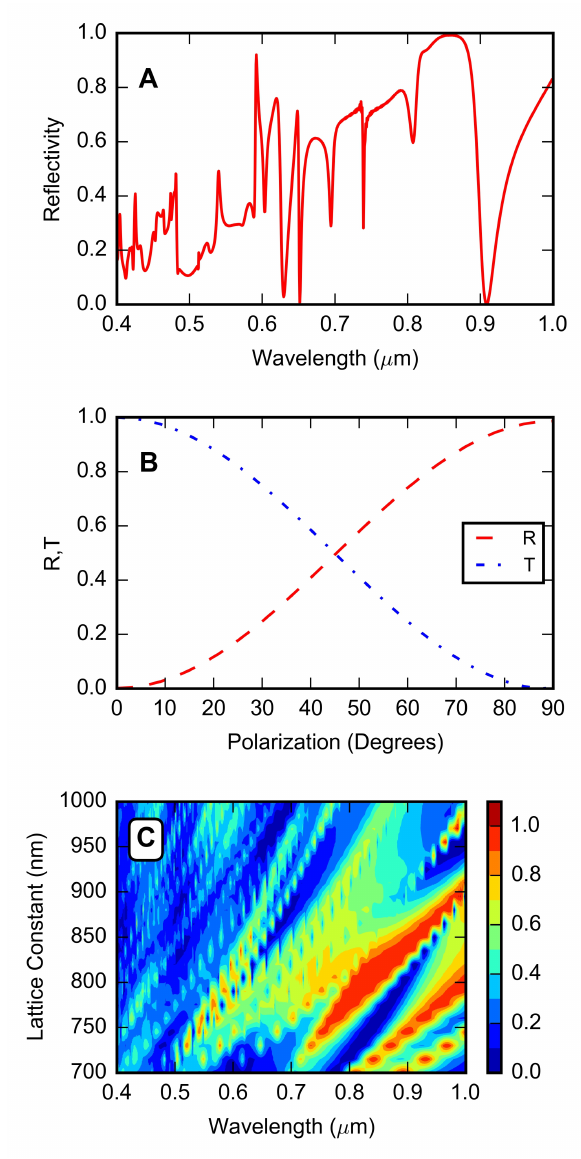
Fig. 10. (A) Reflectivity vs. wavelength calculated using FDTD sim- ulations. (B) Reflectivity, R , and transmissivity, T , vs. polarization angle. Polarization selective simulations were done using elliptical holes. (C) Wavelength reflectivities are shown with varying lattice constant. All simulations were done with a membrane thickness of 500 nm.